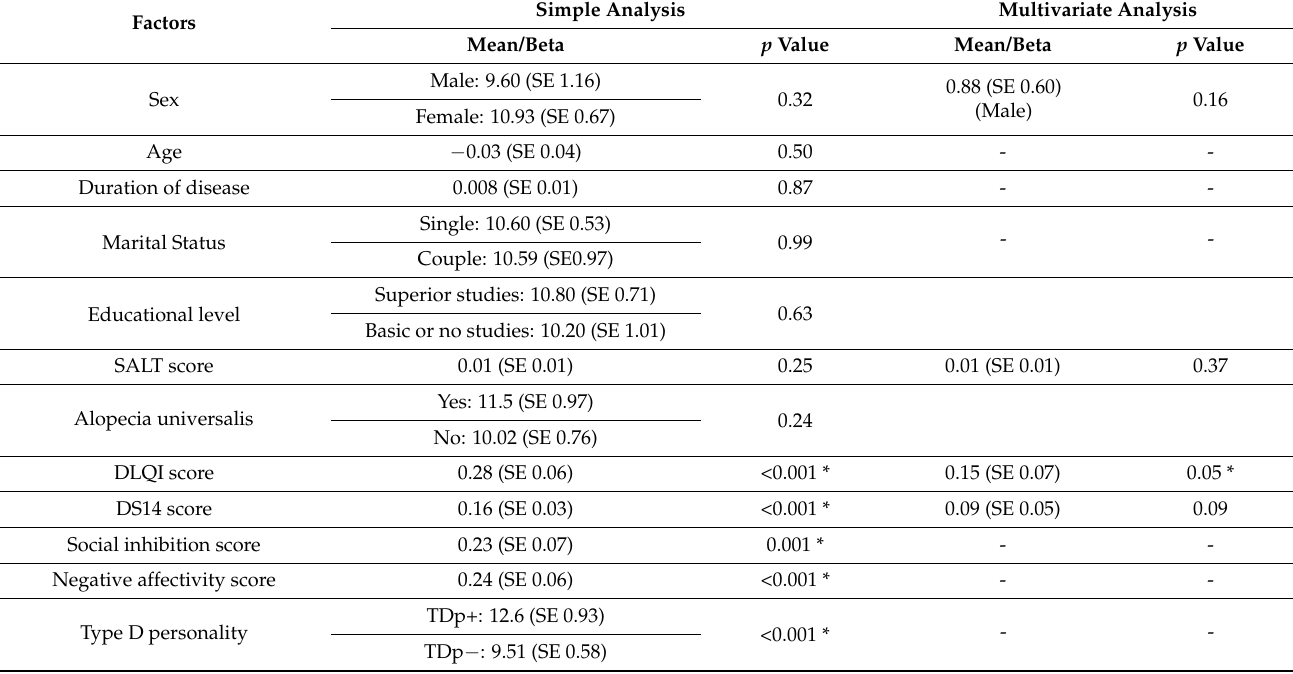
Table 3. Univariate analysis for PSQI index. Associated clinical and socio-demographic